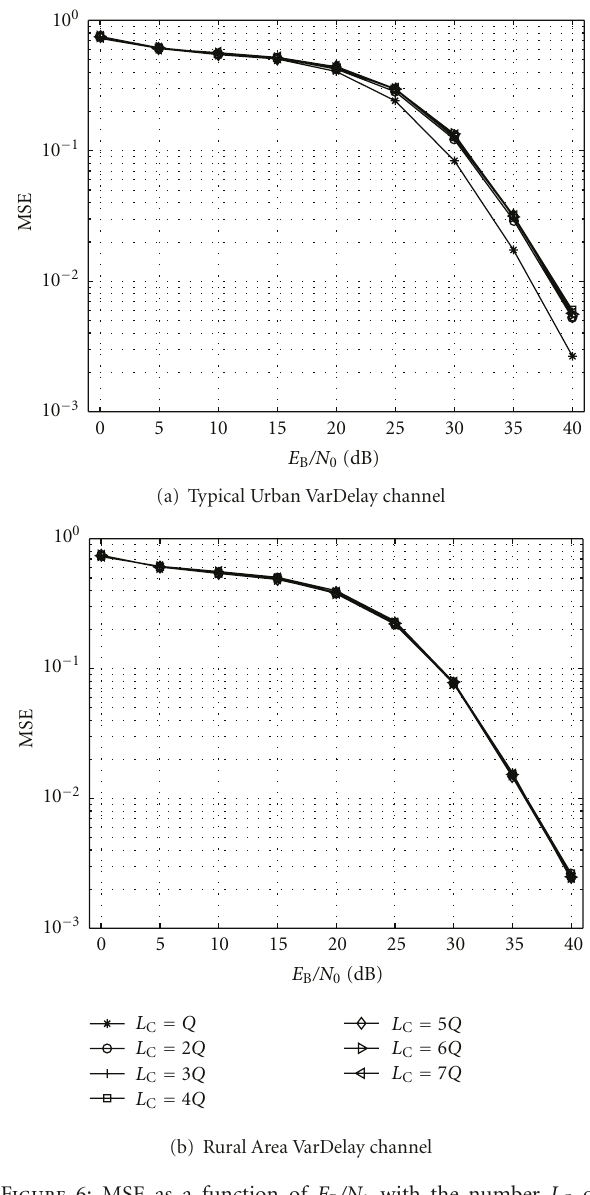
Figure 6: MSE as a function of E B /N 0 with the number L C of channel delay taps as parameter for (a) Typical Urban VarDelay and (b) Rural Area VarDelay channel assuming that Q = 8, K = 30, U = 1, v = 0km/h, and I =